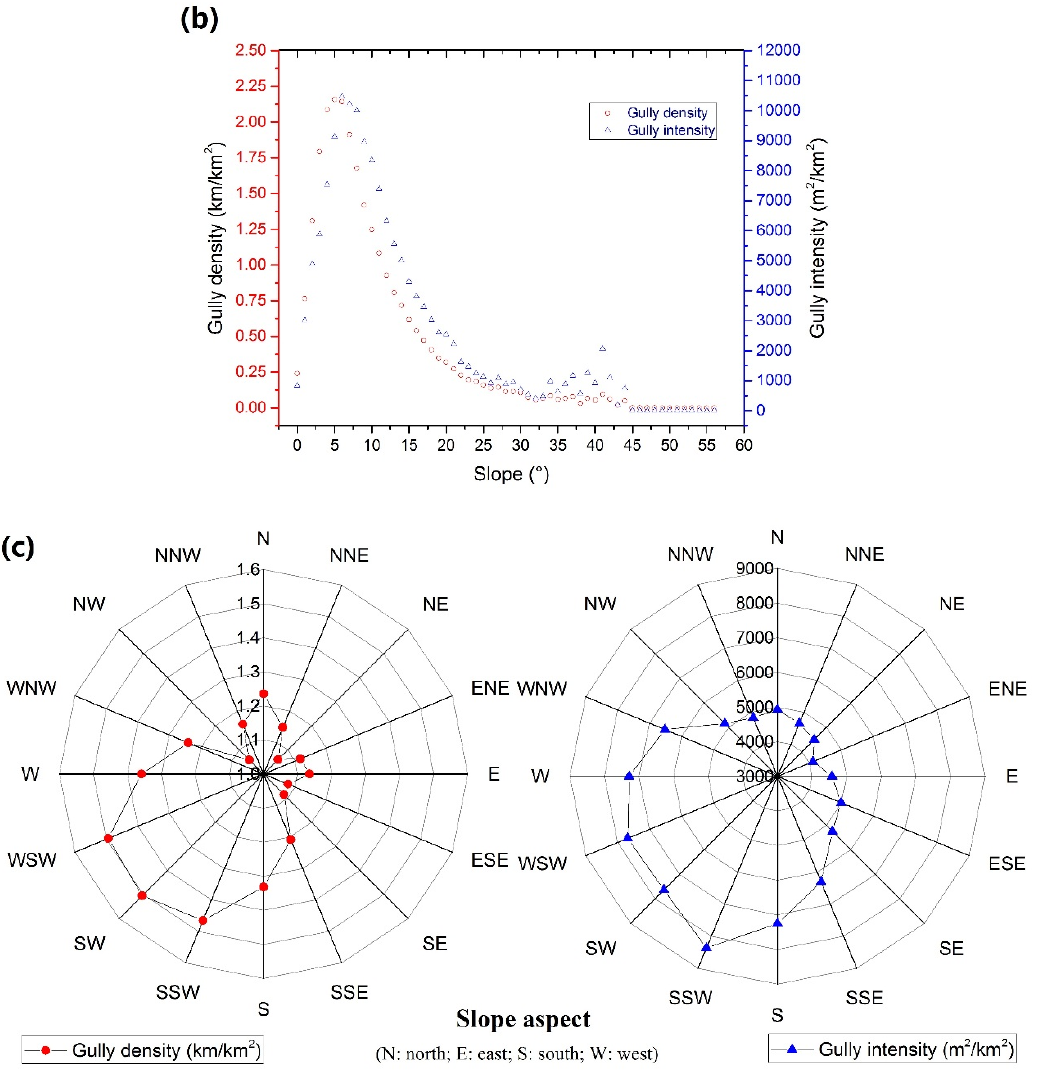
Figure 6. Topographic differentiation of gully erosion: ( a ) elevation; ( b ) slope; and ( c ) slope aspect.